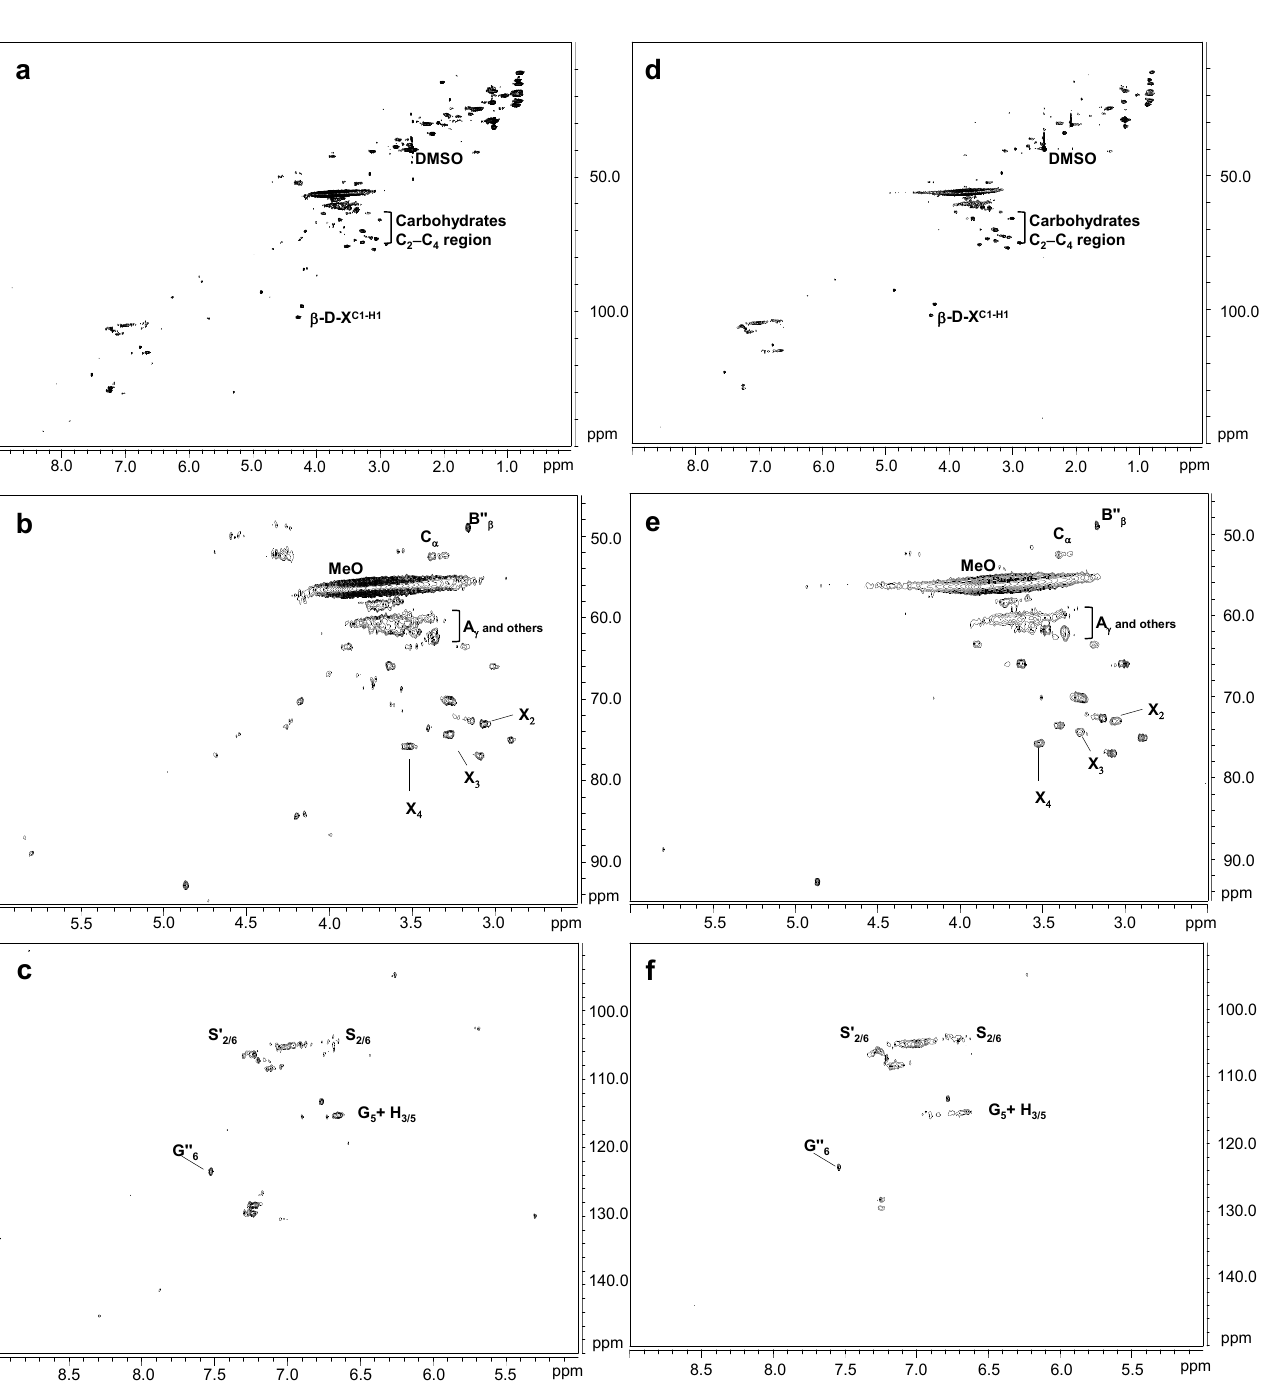
Figure 5. HSQC 2D-NMR spectra of laccase-treated Kraft lignins. Whole spectrum, δ C / δ H Figure 5. HSQC 2D ‐ NMR spectra of laccase ‐ treated Kraft lignins. Whole spectrum, δ C / δ H 0.0– 150.0/0.0–9.0, for SiLA ‐ KL2 ( a ) and MtL ‐ KL2 ( d ); aliphatic oxygenated region, δ C / δ H 45.0–95.0/2.5– 0.0–150.0/0.0–9.0, for SiLA-KL2 ( a ) and MtL-KL2 ( d ); aliphatic oxygenated region, δ C / δ H 6.0 ppm, for SiLA ‐ KL2 ( b ) and MtL ‐ KL2 ( e ); aromatic region, δ C / δ H 90.0–150.0/5.0–9.0 ppm, for 45.0–95.0/2.5–6.0 ppm, for SiLA-KL2 ( b ) and MtL-KL2 ( e ); aromatic region, δ C / δ H SiLA ‐ KL2 ( c ) and MtL ‐ KL2 ( f ).